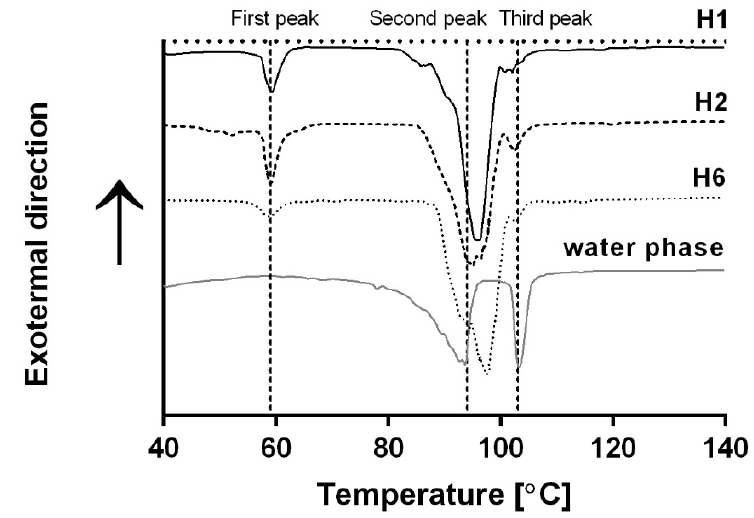
Figure 2. Di ff erential scanning calorimetry (DSC) thermogram (3 ◦ C min − 1 ) of H1 (black curve), H2 Figure 2. Differential scanning calorimetry (DSC) thermogram (3 °C min − 1 ) of H1 (black curve), H2 (dashed black curve), H6 (dotted gray curve), and the water phase (gray (dashed black curve), H6 (dotted gray curve), and the water phase (gray curve).